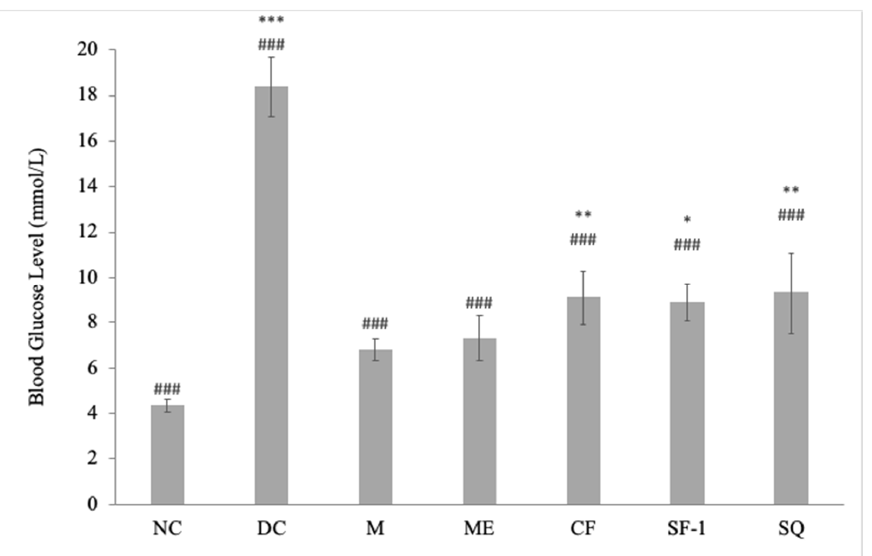
Figure 3. Effects of S. polyanthum ’s active extract, fraction, and subfraction on the blood glucose levels of streptozotocin-induced diabetic rats after being treated orally twice daily for twelve days. NC, normal control (normal saline, 10 mL/kg); DC, diabetic control (normal saline, 10 mL/kg); M, metformin (500 mg/kg); ME, methanolic extract (1 g/kg); CF, chloroform fraction (500 mg/kg); SF-1, n -hexane fraction (250 mg/kg); SQ, squalene (160 mg/kg). The values are expressed as mean ± SEM ( n = 6). # indicates significant differences as compared to the DC ( ### p < 0.001). * indicates significant differences compared to the NC (*** p < 0.001, ** p < 0.01, and * p < 0.05) as analyzed using Dunnett’s as post hoc test.